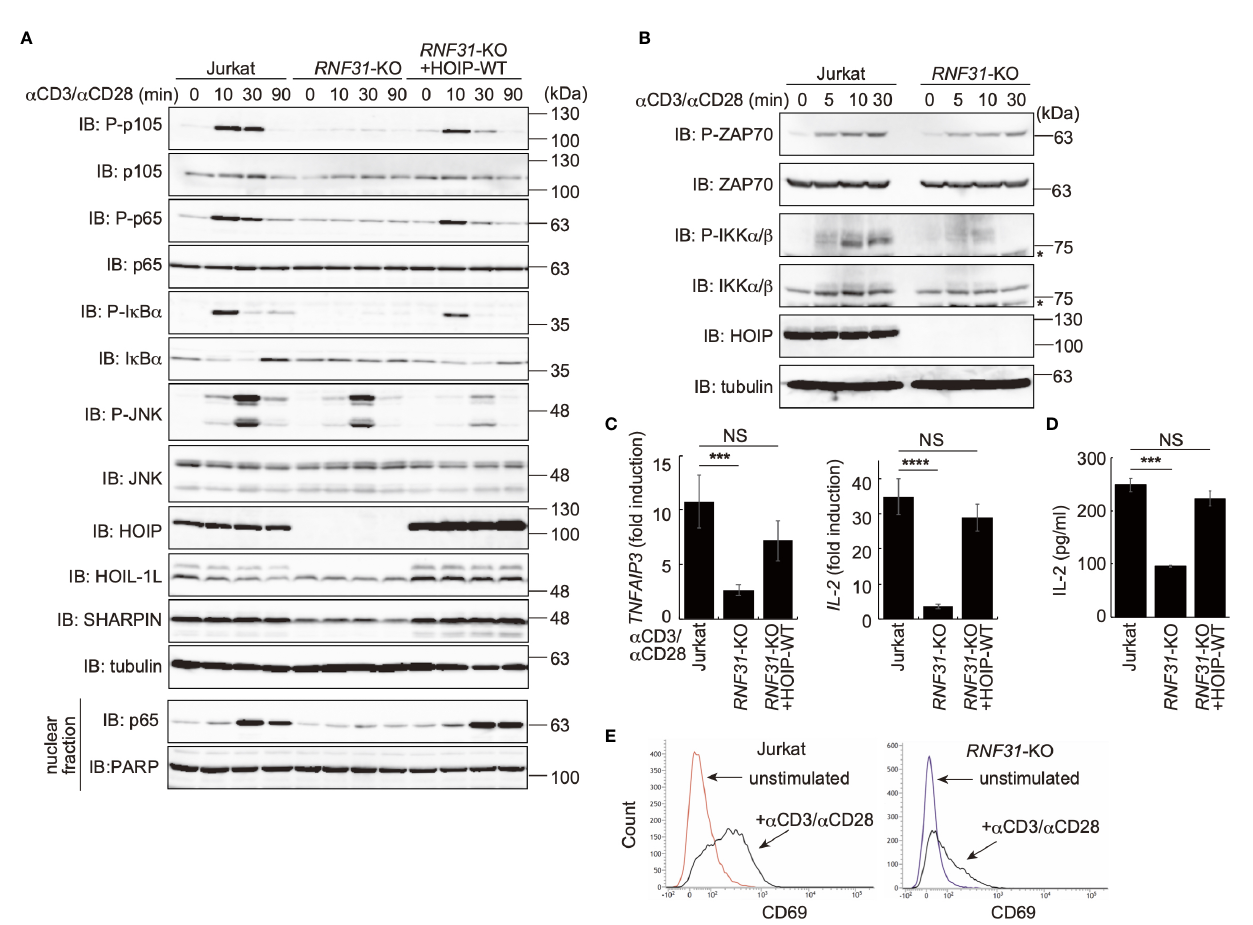
FIGURE 1 | LUBAC is necessary for the TCR-mediated NF- k B activation pathway. (A) Parental Jurkat cells, HOIP -de fi cient cells ( RNF31 -KO), or WT-HOIP-restored RNF31 -KO cells ( RNF31 -KO+HOIP-WT) were stimulated with 1 m g/ml each of anti-CD3 and anti-CD28 antibodies for the indicated periods of time. Cell lysates and nuclear fractions were immunoblotted with the indicated antibodies. (B) Impaired IKK activation in RNF31 -KO cells. WT or RNF31 -de fi cient Jurkat cells were stimulated and analyzed as in (A) , using the indicated antibodies. *nonspeci fi c signal. (C) Reduced expression of TCR-mediated NF- k B target genes in RNF31 -KO cells. Cells were stimulated with anti-CD3 and anti-CD28 antibodies as in (A) for 1 h, and qPCR analyses were performed. (D) LUBAC activity is required for ef fi cient IL-2 secretion. Cells were stimulated with 5 m g/ml each of anti-CD3 and anti-CD28 antibodies for 18 h, and secreted IL-2 was quanti fi ed by ELISA. (E) The expression of T cell activation marker CD69 was suppressed in RNF31 -KO Jurkat cells. WT or RNF31 -de fi cient Jurkat cells were stimulated with 3 m g/ml each of anti-CD3 and anti-CD28 antibodies for 20 h. The expression of CD69 was analyzed by a fl ow cytometer. (C, D) Data are shown as Means ±SD ( n = 3). *** P <0.001, **** P <0.0001, NS, not signi fi